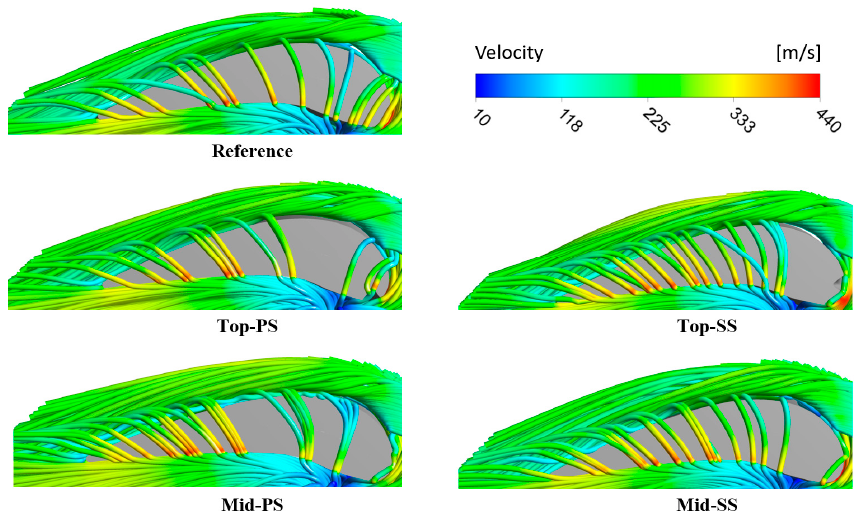
Figure 4. Velocity streamline of the tip-leakage flow passing through the R 1 blade tip under various types of rotor blades. The contour level is defined as the velocity passing though the blade tip.